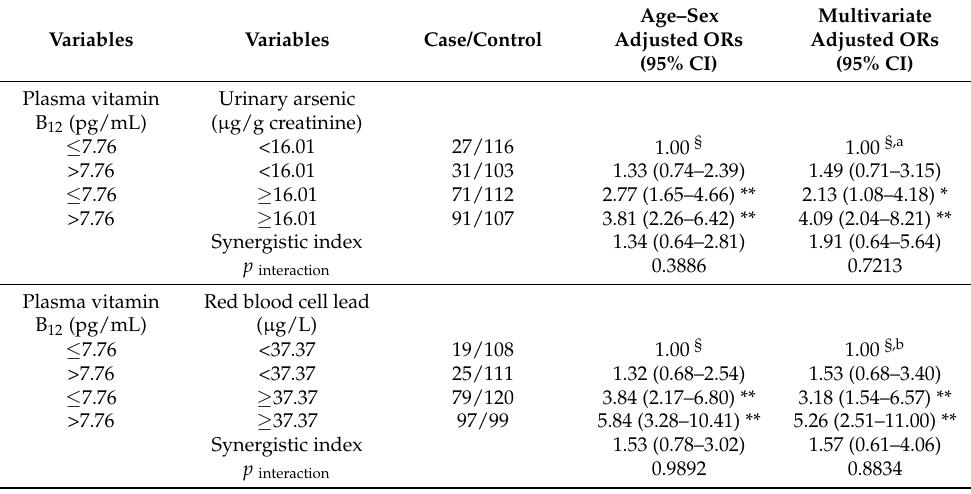
Table 3. The interaction between plasma vitamin B 12 , urinary arsenic, and red blood cell lead and cadmium levels on